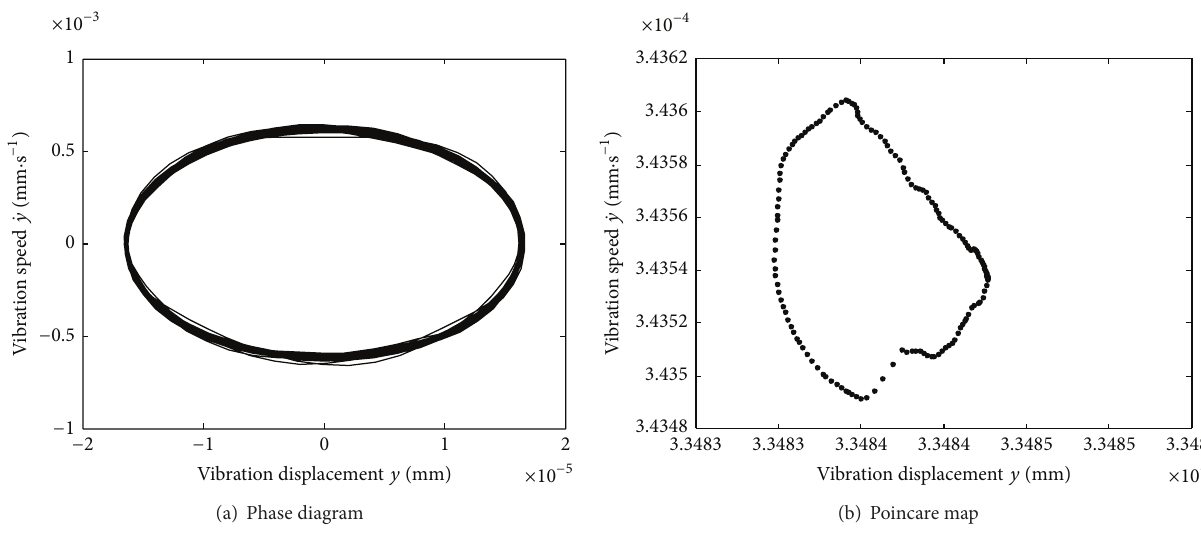
Figure 13: Chaotic motion when 𝜎 = 50 Hz and 𝜀𝐹 = 0.45